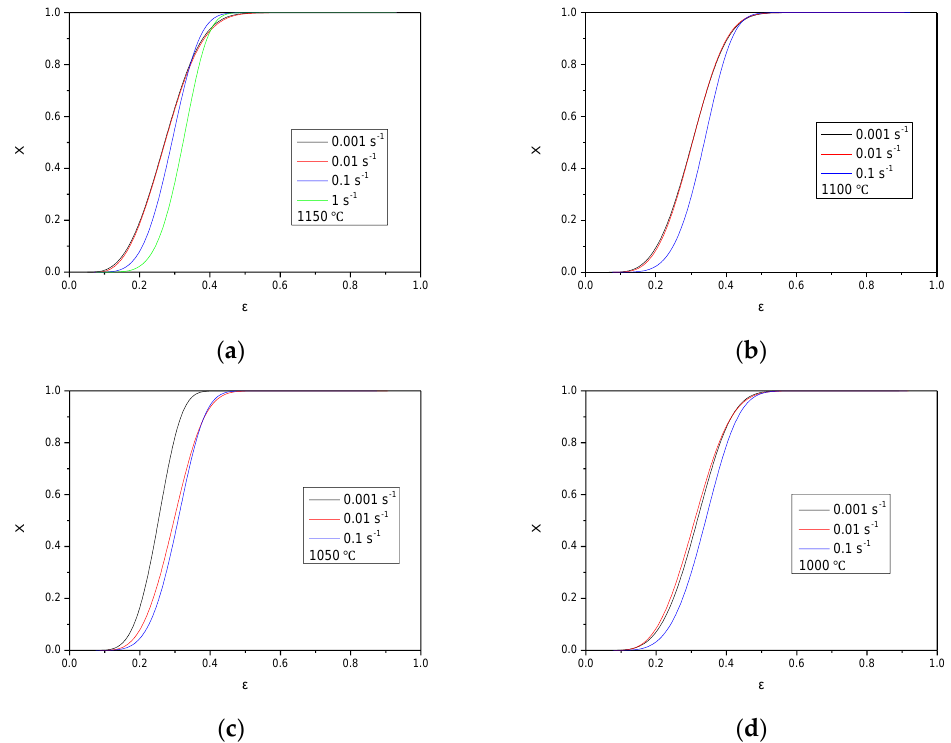
Figure 10. The curves of DRX kinetics under various conditions: ( a ) 1150 °C, ( b ) 1100 °C, ( c ) 1050 °C, and ( d ) 1000 °C.